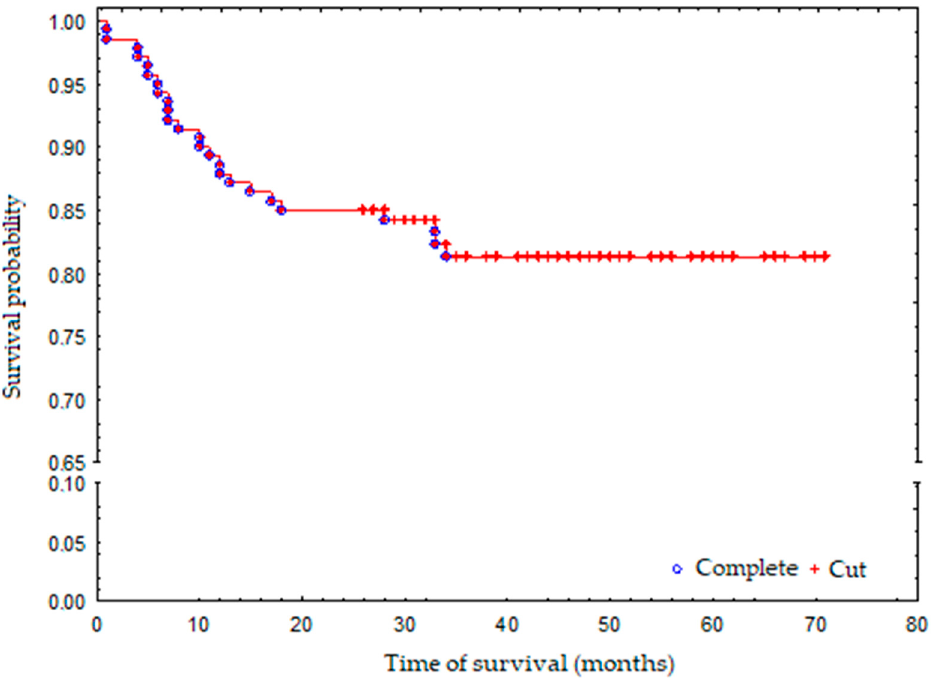
Figure 1. Survival probability in the whole group. . Table 1. Comparison of distribution of nominal variables in the whole group and between NSS ‐ treated and TA ‐ treated group.